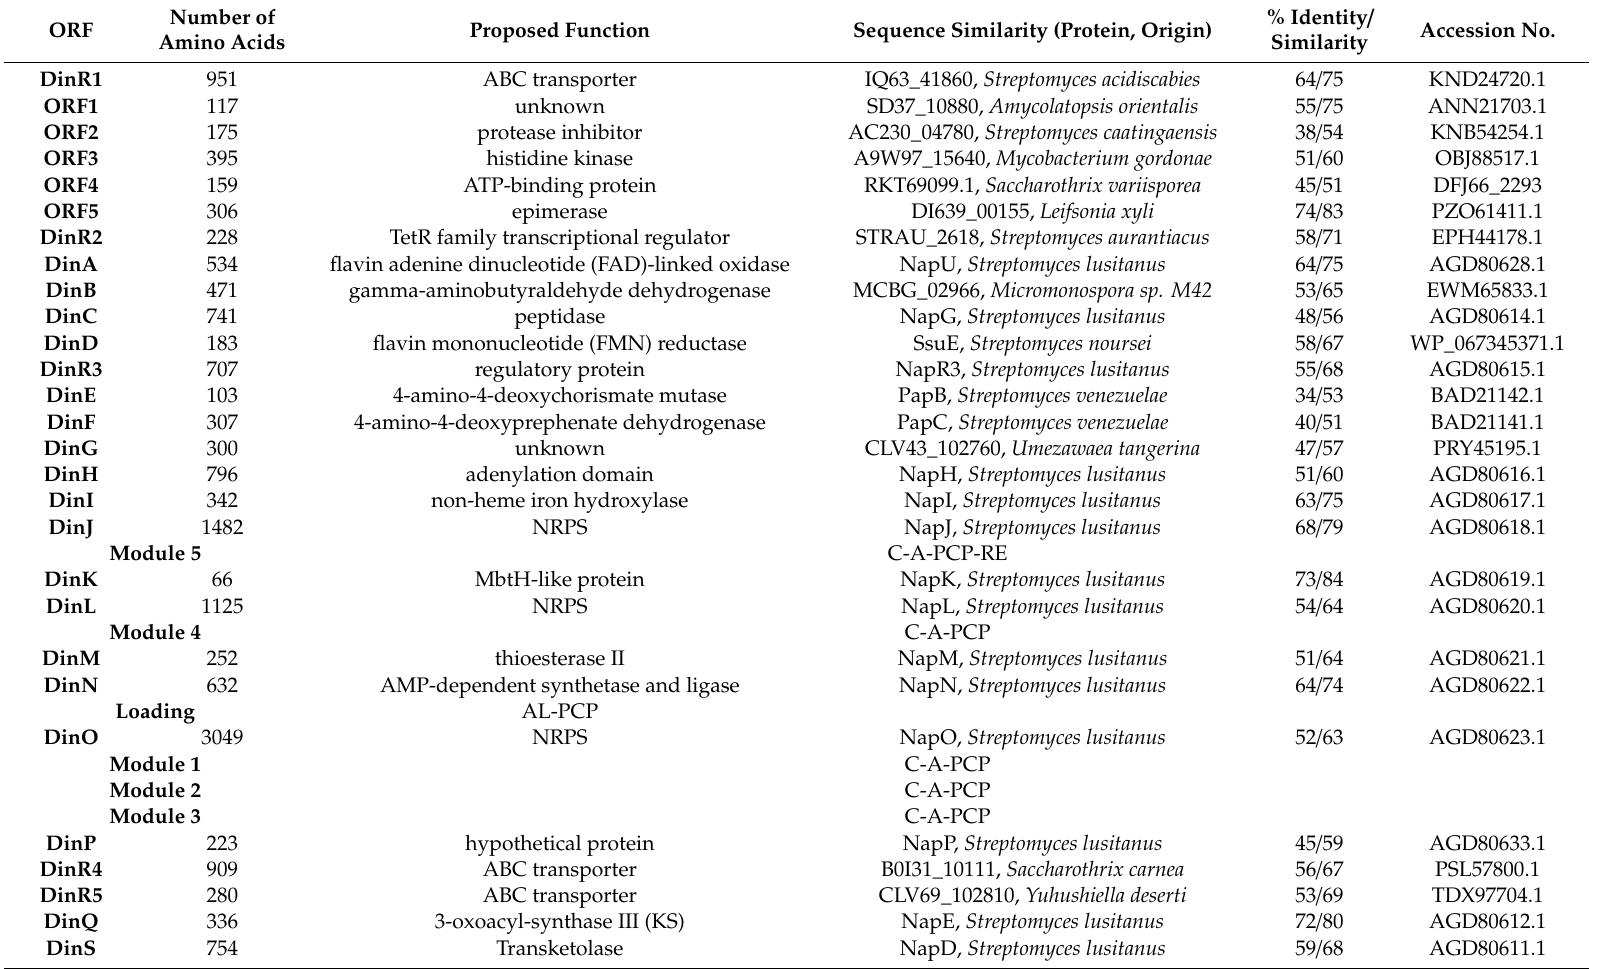
Table 1. Deduced functions of ORFs in the dnacin B1 biosynthetic gene